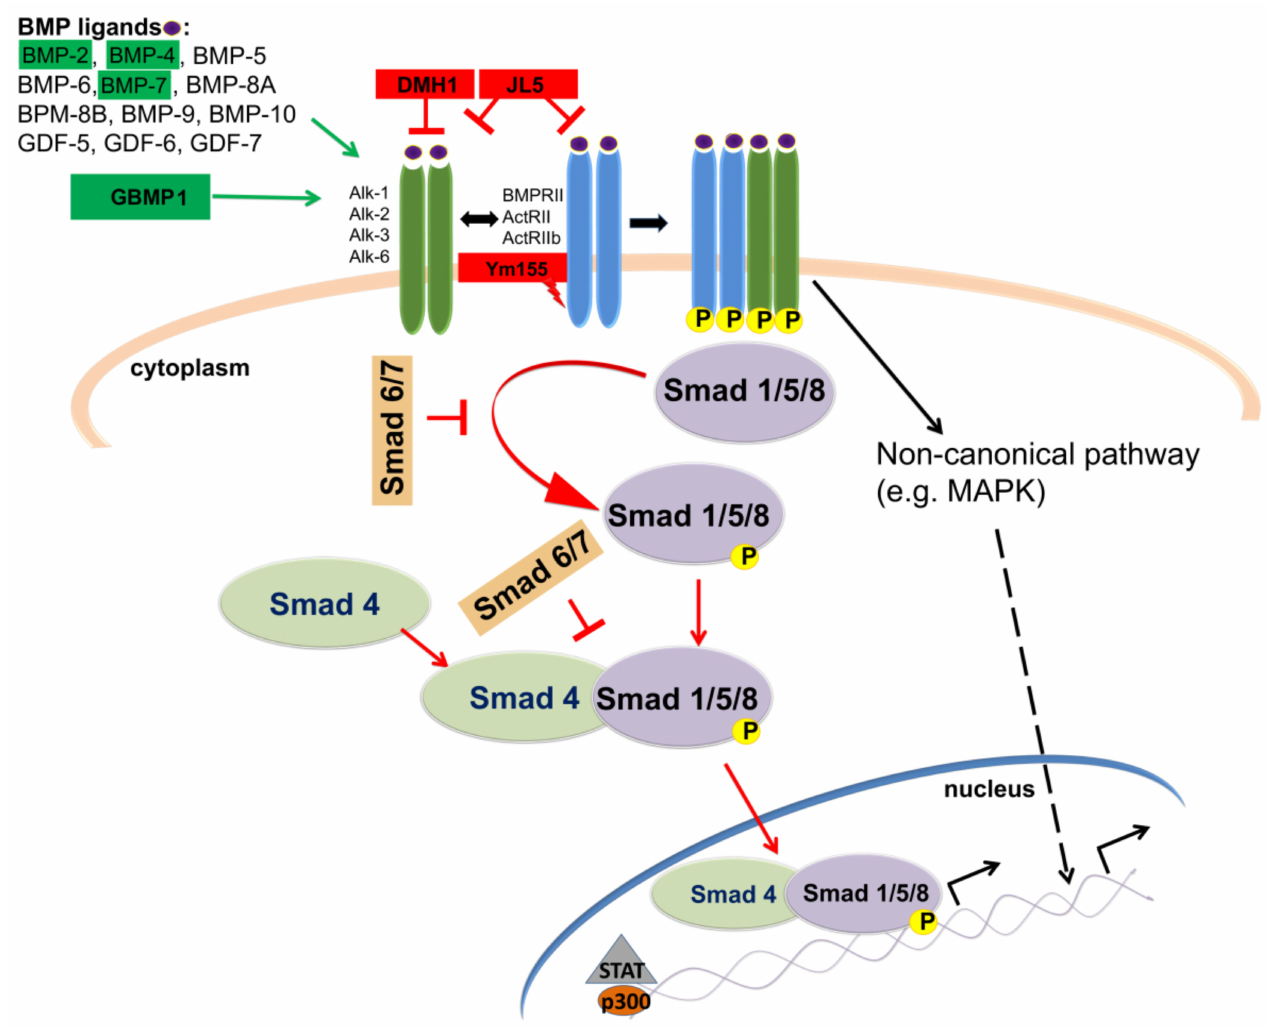
Figure 6. Overview of the canonical BMP cell signaling pathway and molecules investigated for potential therapeutic intervention in GBM. In canonical pathway, various BMP ligands binds to two receptor types (type I and type II) to form a heterotetrameric complex, which then binds to and phosphorylates the receptor-activated Smad 1, Smad 5 and Smad 8. Extracellular inhibitors of BMPs including Noggin, Chordin, and Gremlin inhibit activity of this signaling pathway. Activated Smads (Smad 1, 5, and 8) form complexes with Smad 4, enter the cell nucleus and in combination with co-binding partners, such as p300 or STAT, act as transcription factors and activate multiple